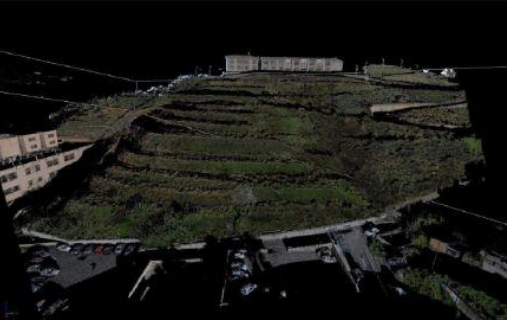
Figure 11. Plane area concerned with indication of station